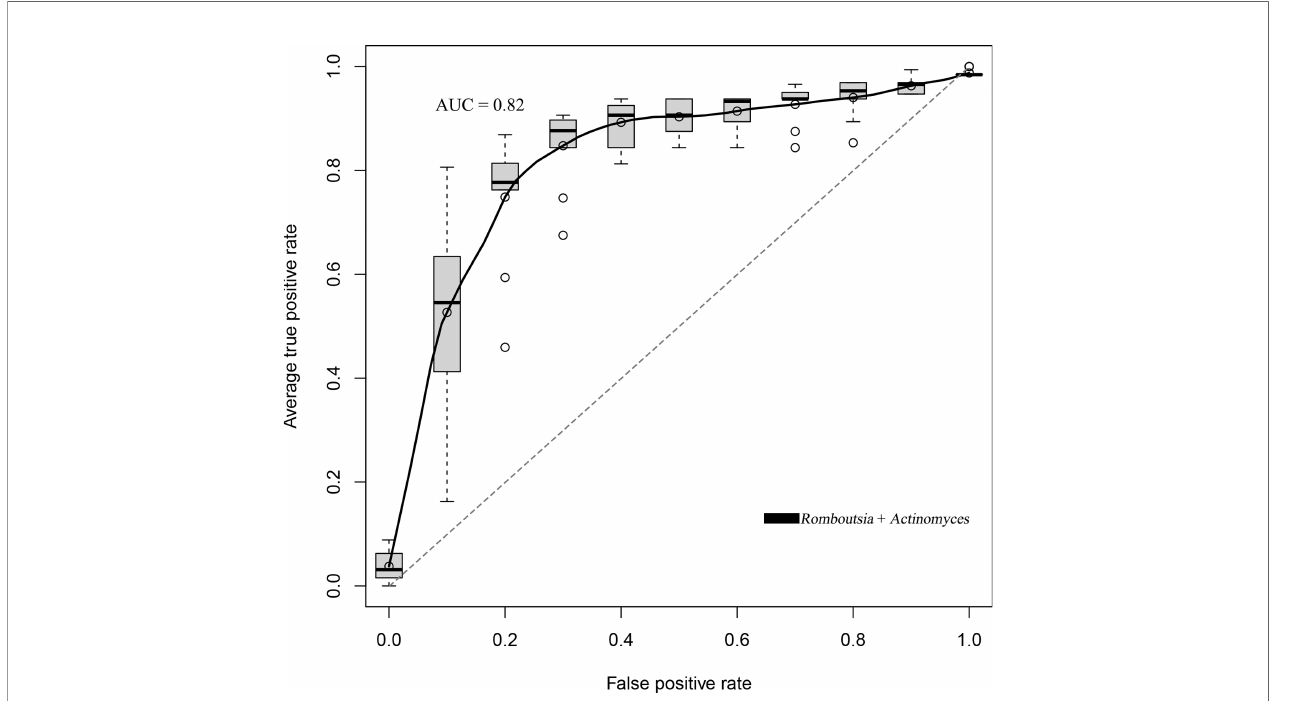
FIGURE 5 | The ROC curve of the random forest model that trades off the rate of true positives against the rate of false positives. The best accuracy of the random forest model was 80.71% with an AUC of